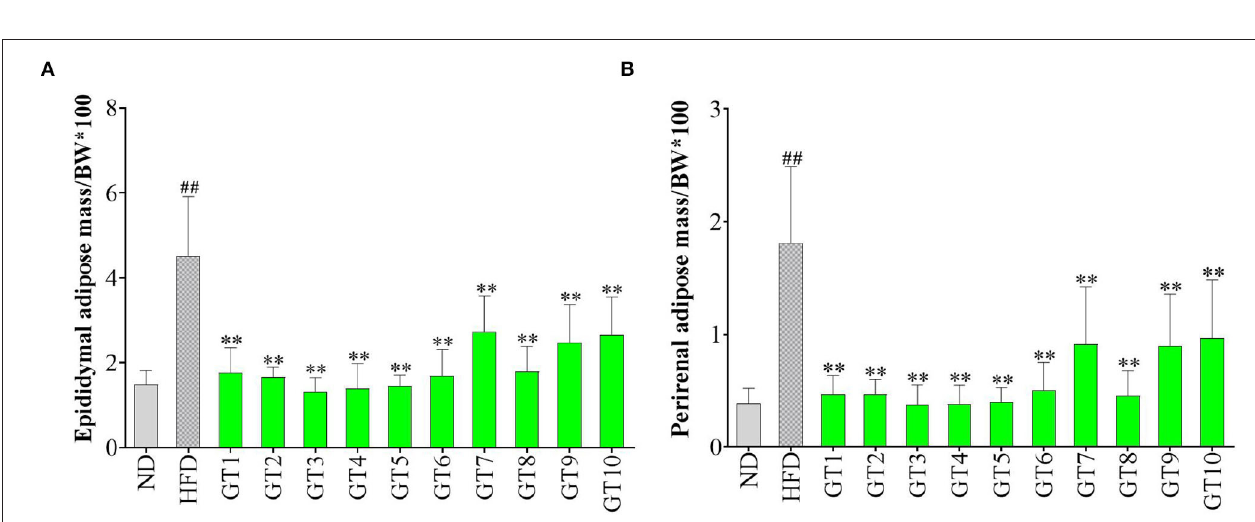
FIGURE 2 | Effects of green teas on visceral adipose tissue. (A) Epididymal adipose mass/BW × 100 and (B) Perirenal adipose mass/BW × 100. ## p < 0.01, the model group vs. the control group; ** p < 0.01, the green tea groups vs. the model group. BW, body weight; ND, normal diet; HFD, high-fat diet; GT1, Dianqing Tea; GT2, Jieyang Chaoqing Tea; GT3, Fenggang Zinc-Selenium-Enriched Tea; GT4, Liping Xiang Tea; GT5, Taiping Houkui Tea; GT6, Xihu Longjing Tea; GT7, Chaoqing Green Tea; GT8, Selenium-Enriched Chaoqing Green Tea; GT9, Selenium-Enriched Matcha; GT10, Seven Star Matcha.